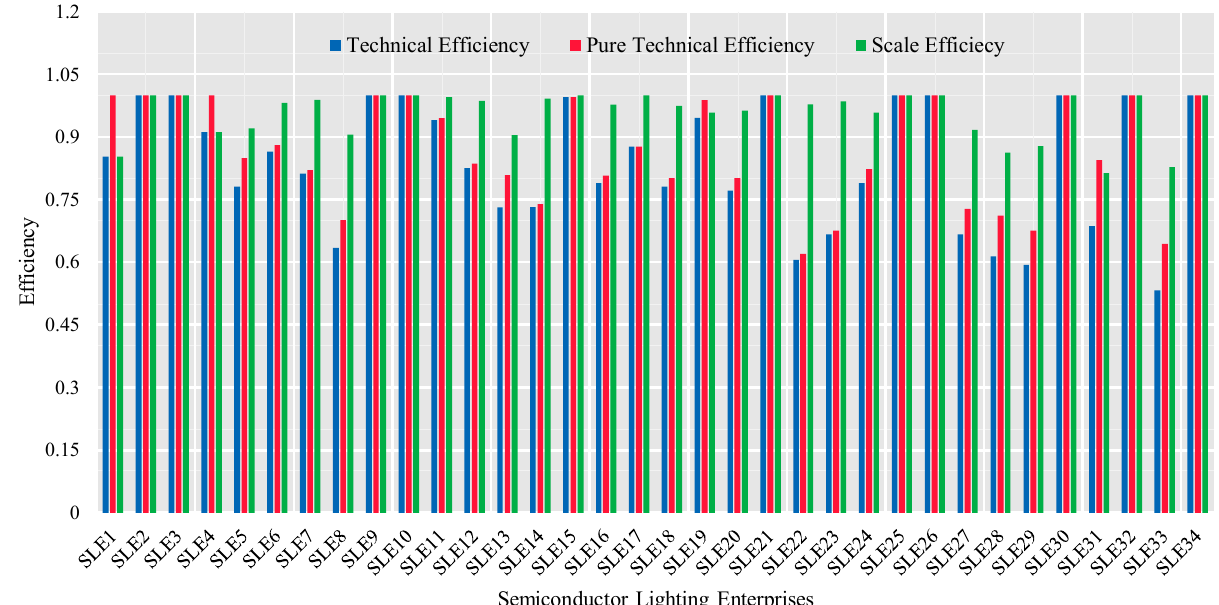
Figure 7. Comprehensive technical efficiency evaluation results of 34 Chinese LED energy enterprises in 2018.